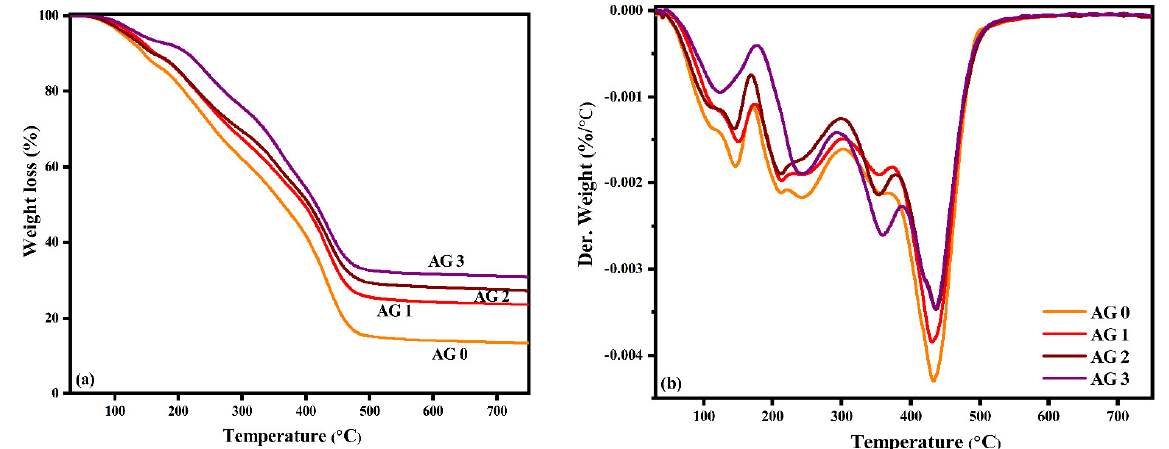
Figure 5. ( a ) Thermogravimetric (TGA) and ( b ) differential thermal analysis (DTA) curves of agar/zeolite/CMC/PVA biomembrane. Table 3. The result of thermogravimetric results.